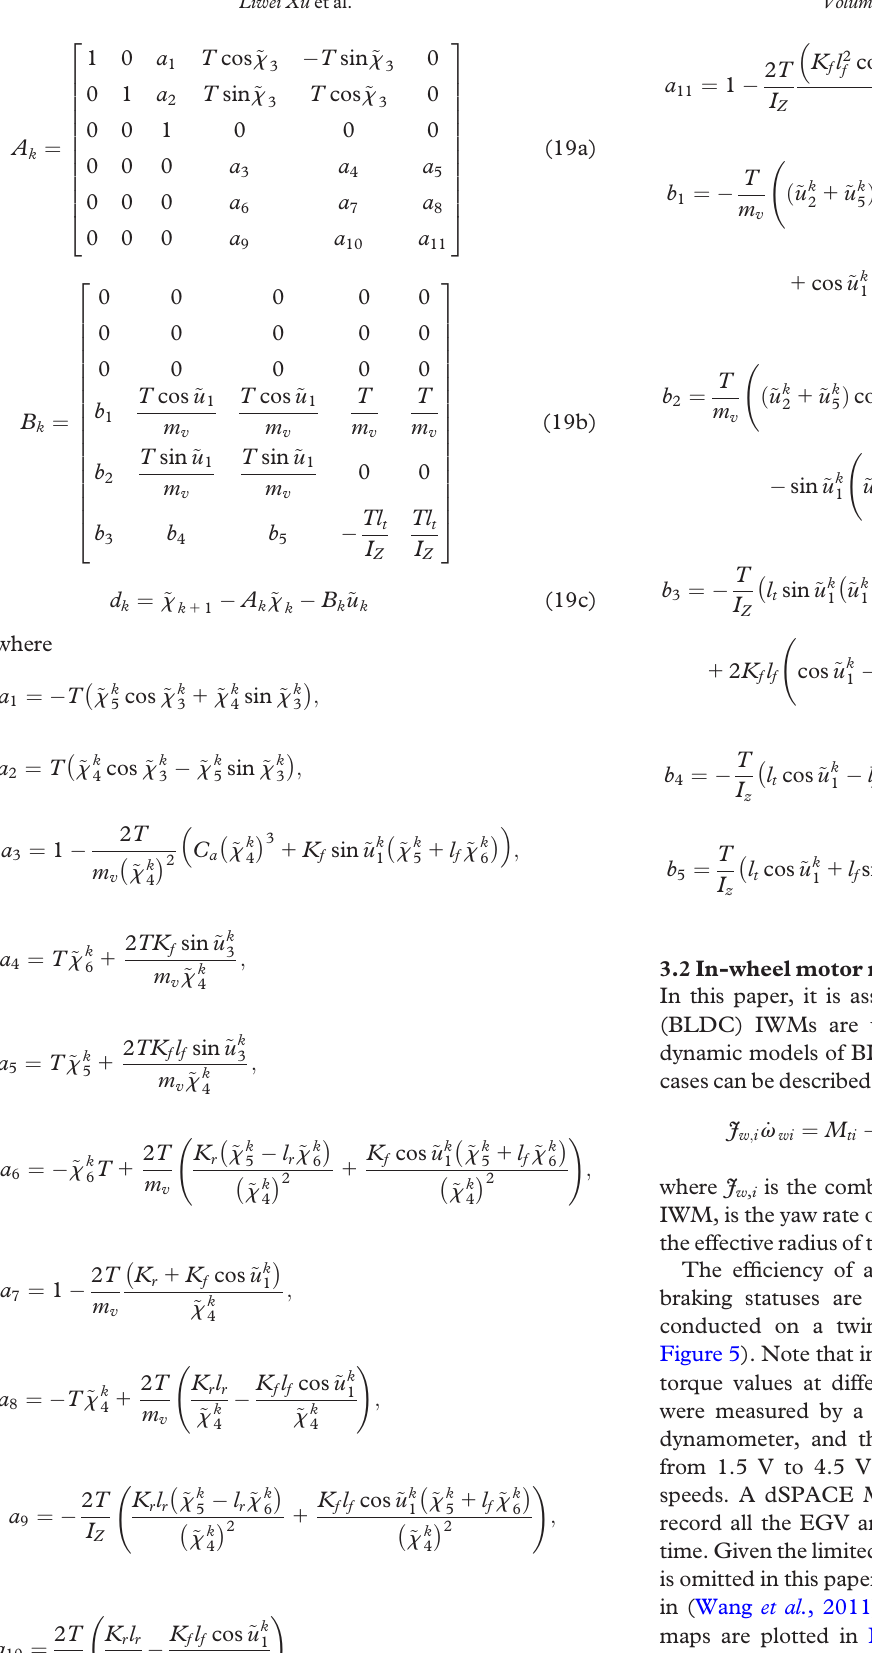
motor ef fi ciency into the ef fi ciency management control, similar to (Chen and Wang, 2014), the polynomial fi